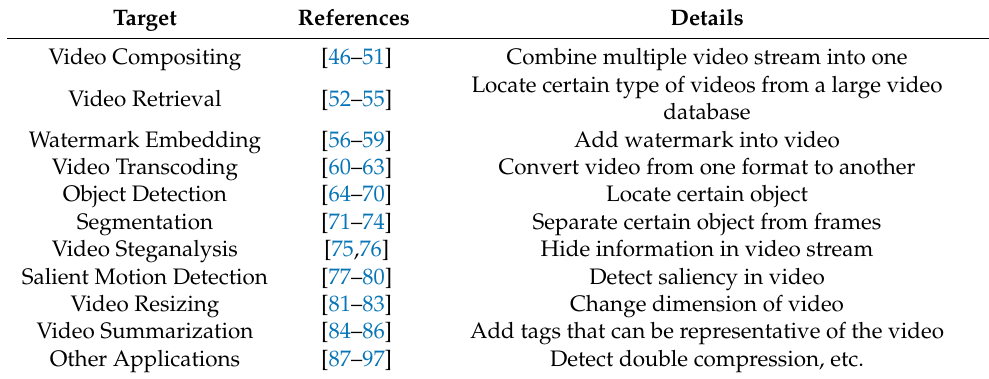
Table 2. Summary of compression domain processing and analysis on video